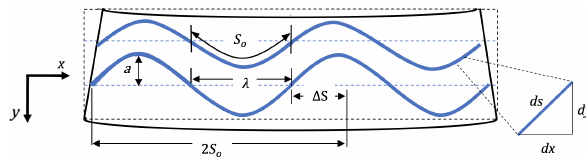
Figure 2: Magified section of the SMPC with a carbon fiber reinforce- ment in the SMP matrix indicating the microbuckling of the fiber in the SMPC under large strain deformation. Note: the